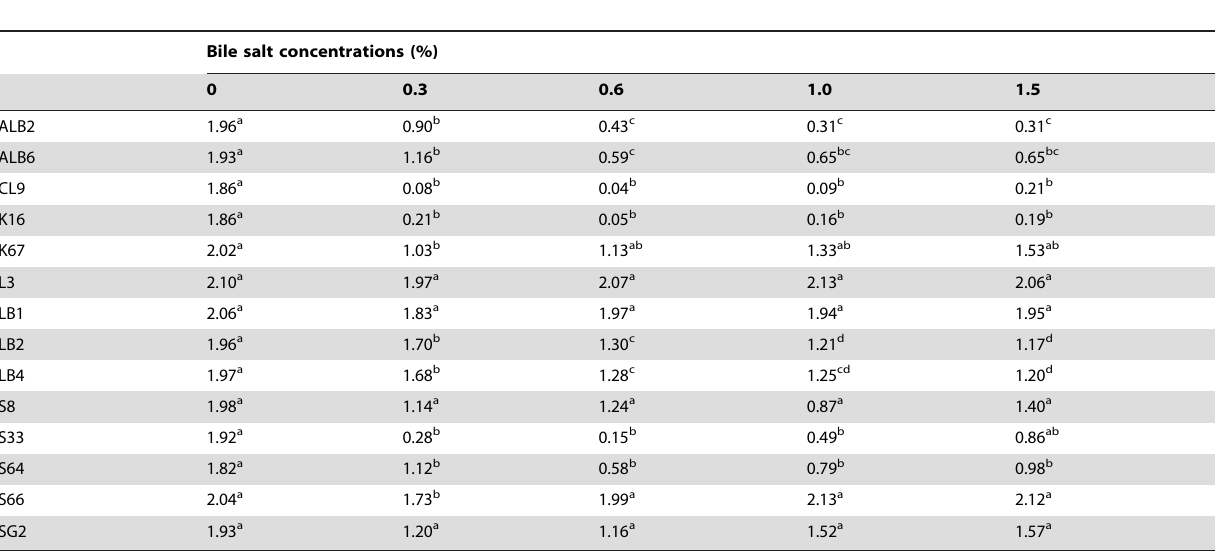
Table 2. Growth (OD 600 ) of selected lactic acid-producing bacterial isolates at different concentrations of bile salt *